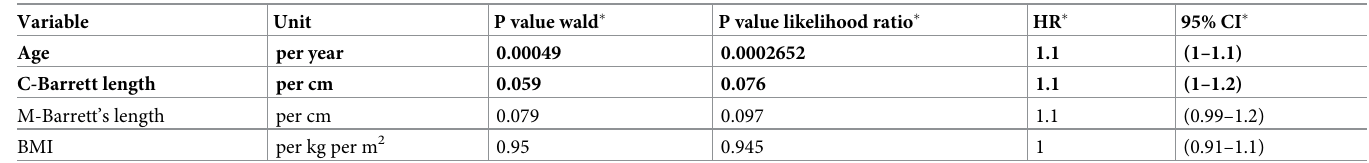
Table 4. Outcomes from univariate regression analysis of the clinical variables.